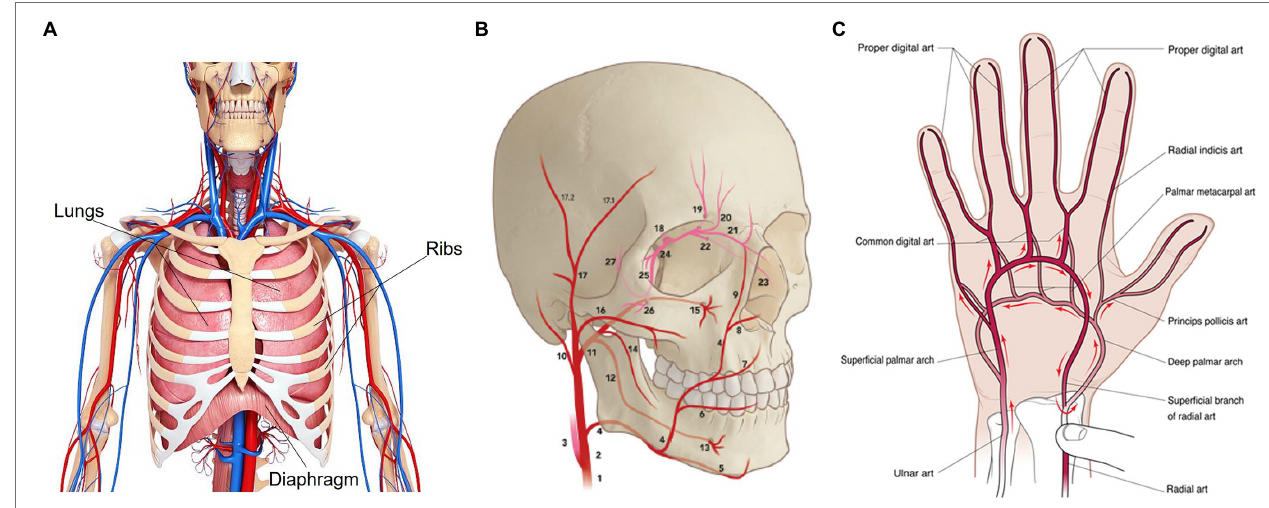
FIGURE 1 | Anatomy of the respiratory system (A) , face ( B ; adapted from von Arx et al., 2018), and hand (C) vascularization (from Habib et al., 2012). In (B) , numbers indicate the main arteries that carry the blood to the forehead and cheeks, specifically: common carotid artery (1), external carotid artery (2), internal carotid artery (3), facial artery (4), transverse facial artery (16), superficial temporal artery (17) and frontal branch (17.1), ophthalmic artery